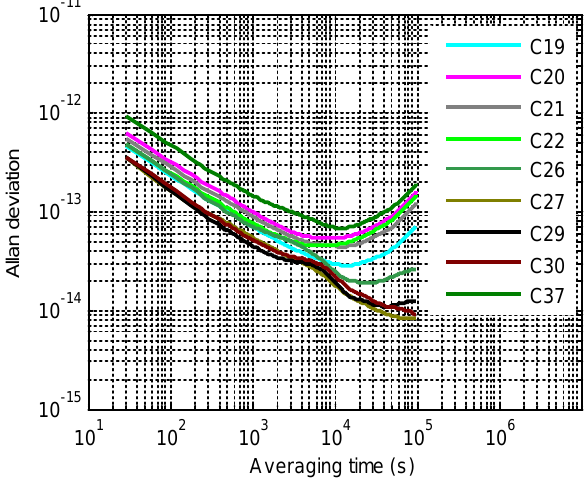
Figure 2. Allan deviations (ADEVs) of detrended clock deviations. Table 2. Noise diffusion coefficients of three BeiDou-3 satellites (passive hydrogen maser (PHM) indicated in italics).